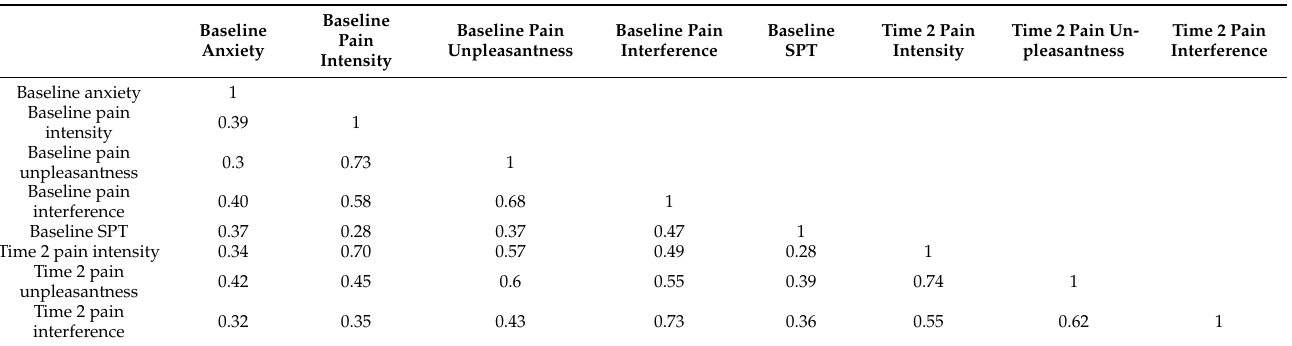
Table 3. Zero-order correlations among variables.